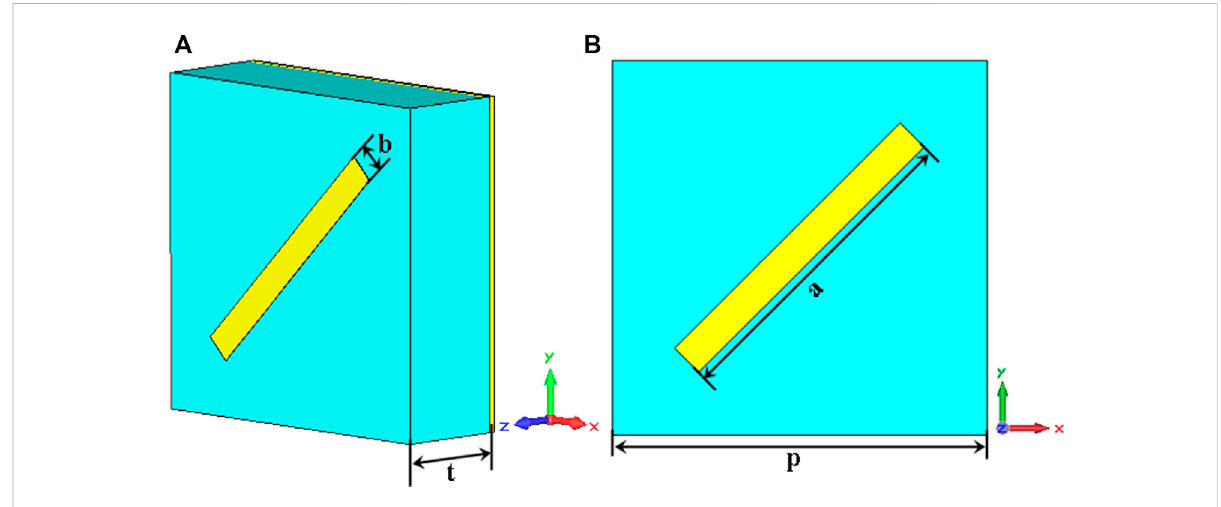
FIGURE 1 (A) Perspective view of the unit cell and (B) front view of the unit